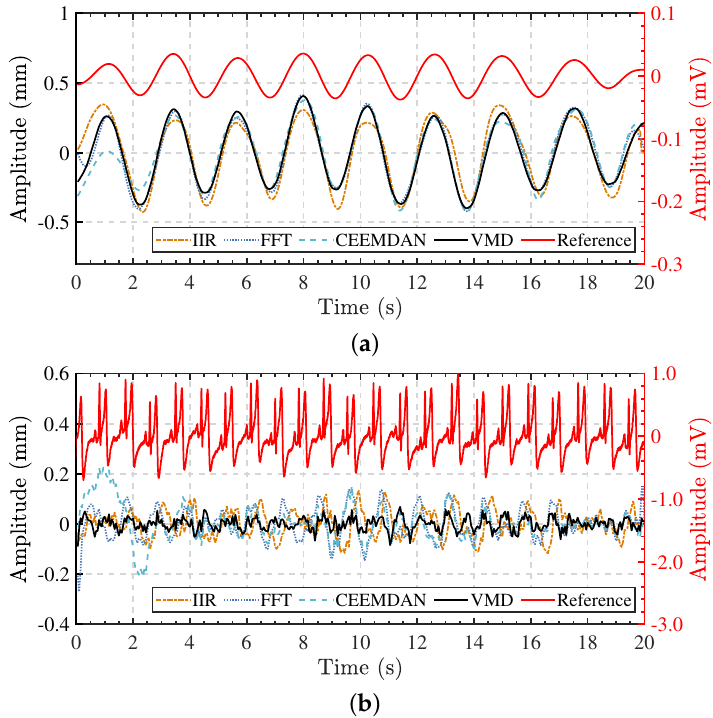
Figure 11. Separation results of respiration and heartbeat patterns for one of the subjects (Subject 1). The red lines are the reference signals (in mV). The other ones are displacement signals (in mm) separated by different algorithms. ( a ) Separated respiration patterns compared with the reference respiration signal. ( b ) Separated heartbeat patterns compared with the reference ECG signal. As apnea may occur during vital signs monitoring, we also display the extracted vital signs signal of Subject 2, who holds his breath at the 12th second. As shown in Figure 12, the vital signs signal captures the change of breathing. Apnea reveals the heartbeat without the effect of respiration, while with normal breathing, it is hard to identify the heartbeat directly. However, by the VMD algorithm, we separate the respiration and heartbeat patterns in both conditions.